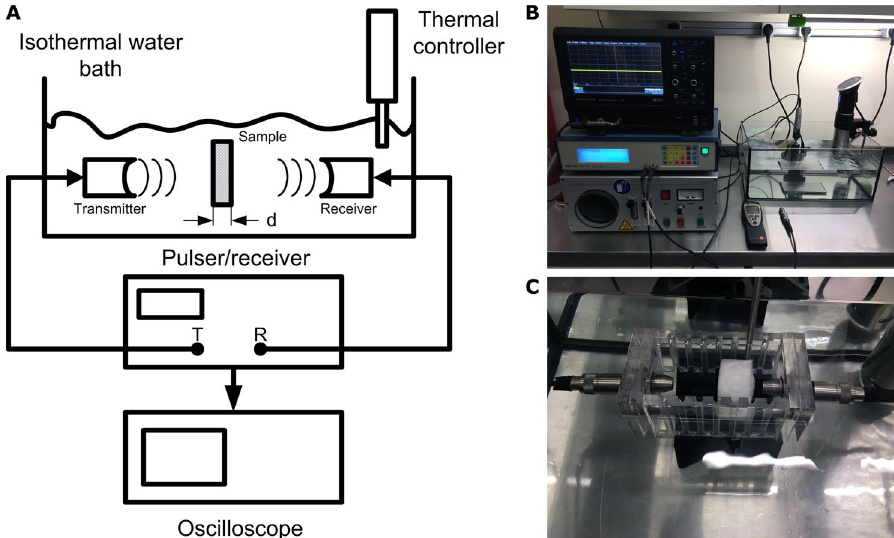
Figure 2. Experimental setup employed for the ultrasound experiments: ( A ) Scheme of through-transmission configuration for ultrasonic spectroscopy. ( B ) General view of equipment. ( C ) Detailed view of the phantom under